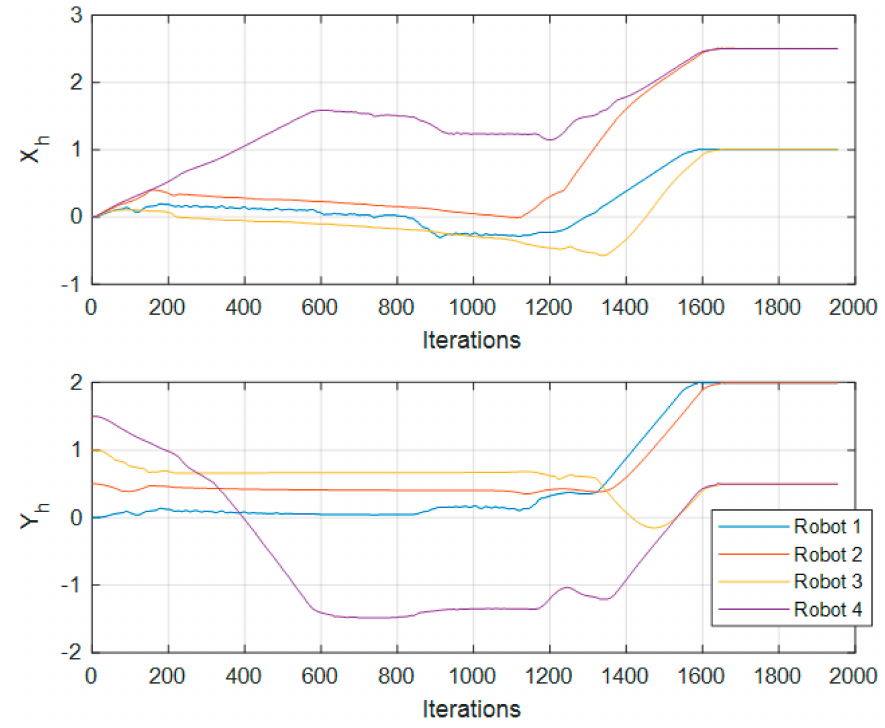
Figure 8. Trajectories along iterations in the 4-robot simulation.